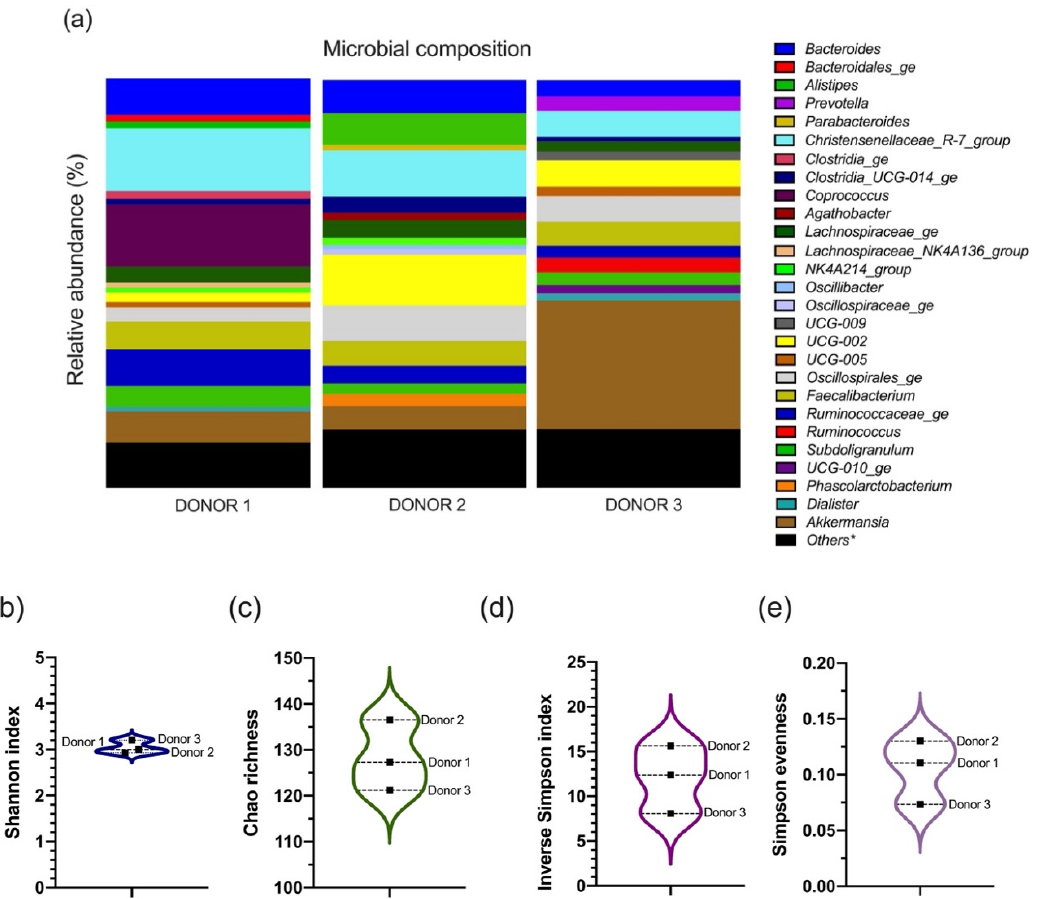
Figure 1. Microbial community analysis in stool samples from donors 1, 2, and 3, as assessed using 16S rRNA Illumina Sequencing. ( a ) Genera abundance histogram (%, left panel) and genus classification (right panel) based on quality-controlled OTU reads. Only bacterial genera with relative abundance >1% in at least one sample are shown, and the rest are included as others * (see details in Supplementary File S2, Table S2). Diversity analysis of the sequencing data is presented as ( b ) Shannon α -diversity index, ( c ) Chao estimator of genus richness, ( d ) Simpson reciprocal α -diversity index, and ( e ) Simpson abundance-derived evenness.